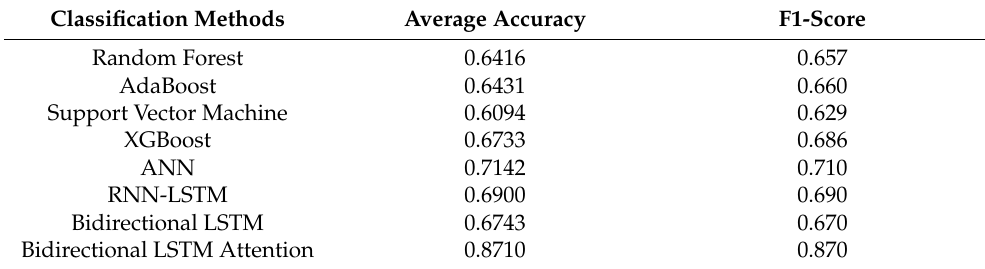
Table 3. Classification result of comparison of the proposed method with other algorithms.